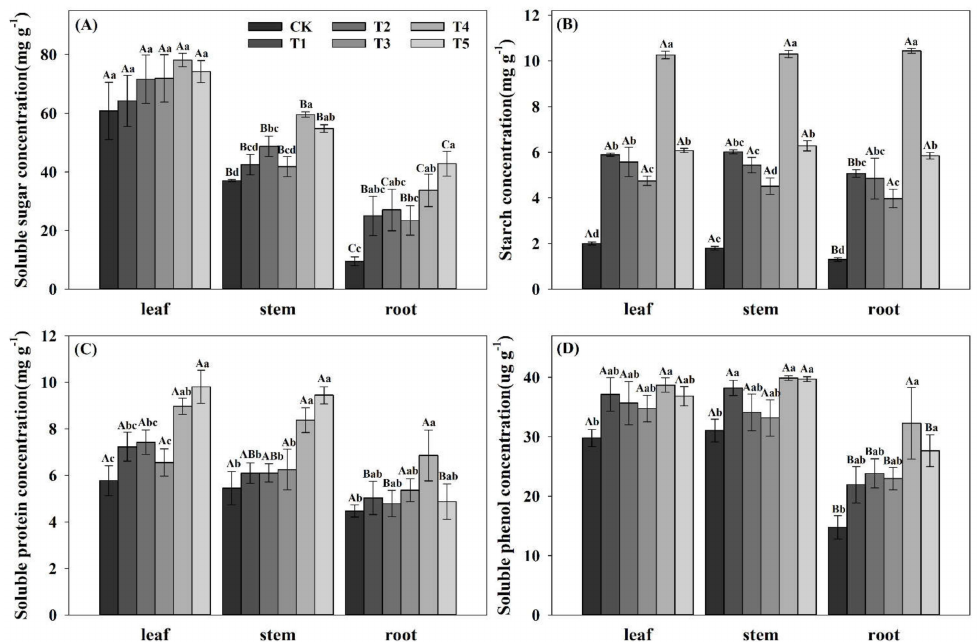
Figure 3. Differences of soluble sugar, starch, soluble protein, and soluble phenol concentrations of pecan seedlings under varying NH 4+ :NO 3 − ratios. Soluble sugar concentrations in leaves, stems and roots of pecan seedlings under varying NH 4+ :NO 3 − ratios ( A ). Starch concentrations in leaves, stems and roots of pecan seedlings under varying NH 4 + :NO 3 − ratios ( B ). Soluble protein concentrations in leaves, stems and roots of pecan seedlings under varying NH 4+ :NO 3 − ratios ( C ). Soluble phenol concentrations in leaves, stems and roots of pecan seedlings under varying NH 4+ :NO 3 − ratios ( D ). Uppercase letters indicate differences between NH 4+ :NO 3 − treatments, and lowercase letters indicate differences between organs, at p <